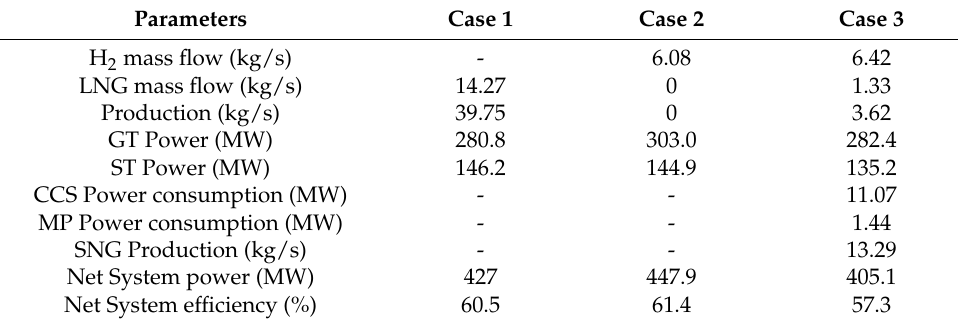
Table 8. Performance analysis